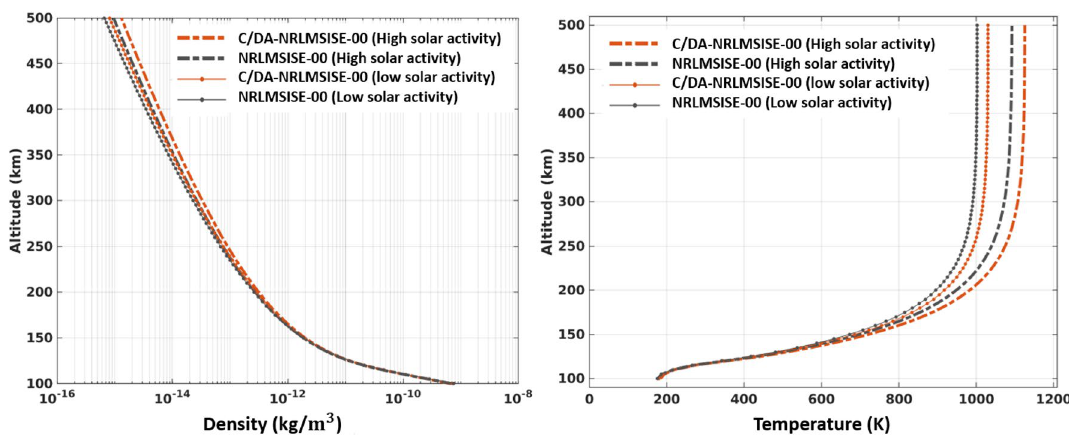
Figure 7. Temperature and density profiles during low solar activity (February 26th, 2015 at 12:00 UT, F 10.7 = 110 , gray) and high solar activity (February 8th, 2015 at 12:00 UT, F 10.7 = 153 , red) conditions. The solid and dashed lines are the corresponding NRLMSISE-00 and C/DA model, respectively. The vertical profile is estimated at latitude 0 ◦ and longitude 0 ◦ . The plots were generated using MATLAB (version R2021a, https:// www. mathw orks.